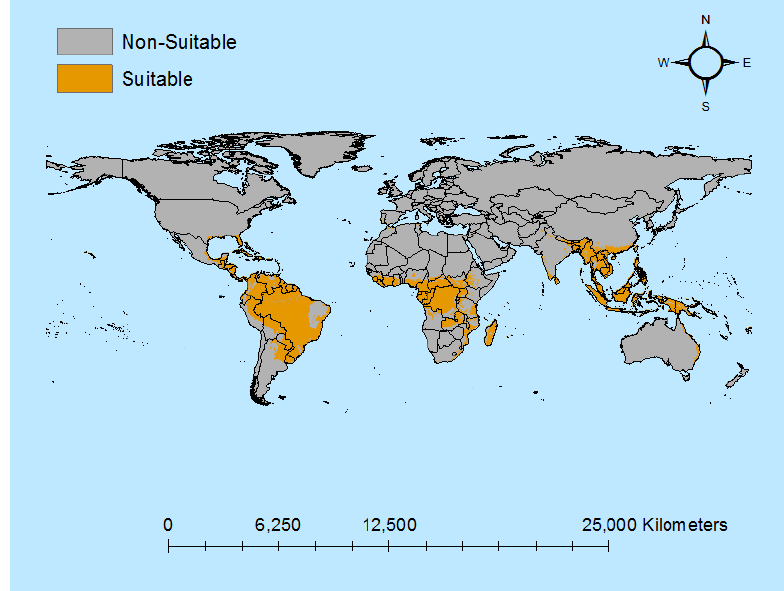
Figure 1. Bananas Growing Suitability Area. Note: This figure depicts banana suitability areas.